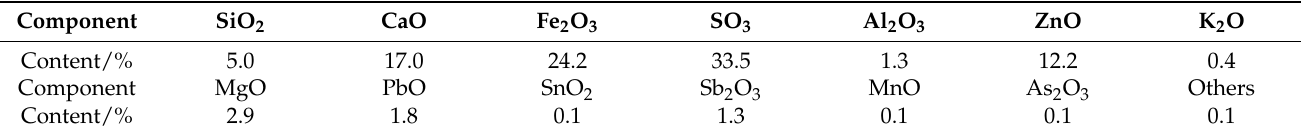
Table 5. Chemical components of Gaofeng